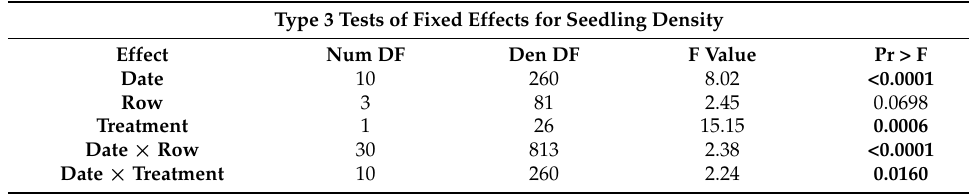
Table 2. Results of mixed model analysis for seedling